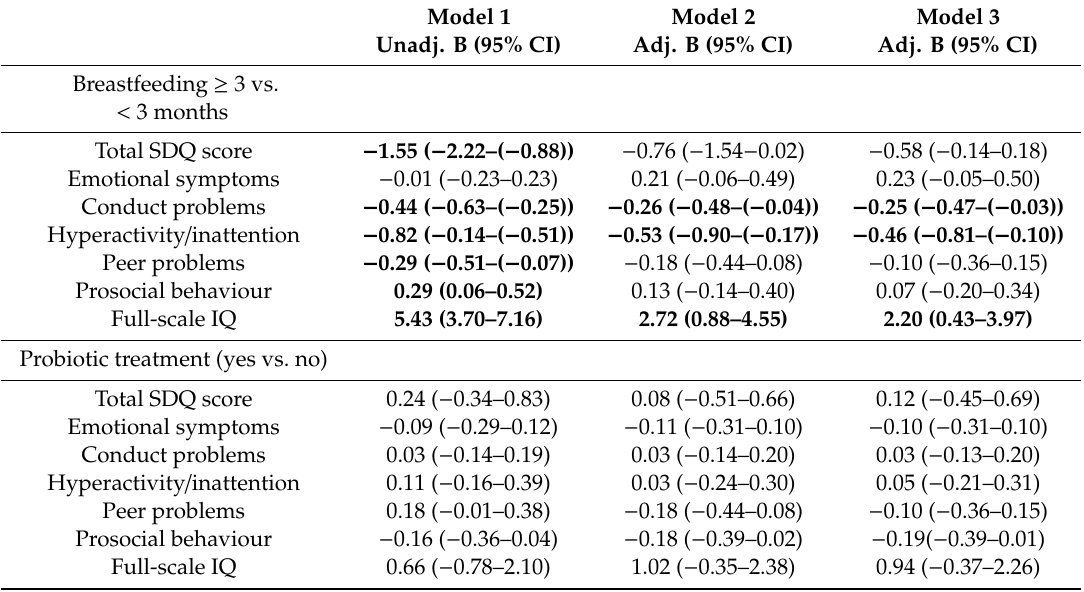
Table A1. Unadjusted and adjusted linear regression analyzes for the outcomes of the strength and di ffi culties questionnaire (SDQ) total and subscores and the intelligence quotient (IQ), considering breastfeeding and probiotic therapy separately as main treatment.